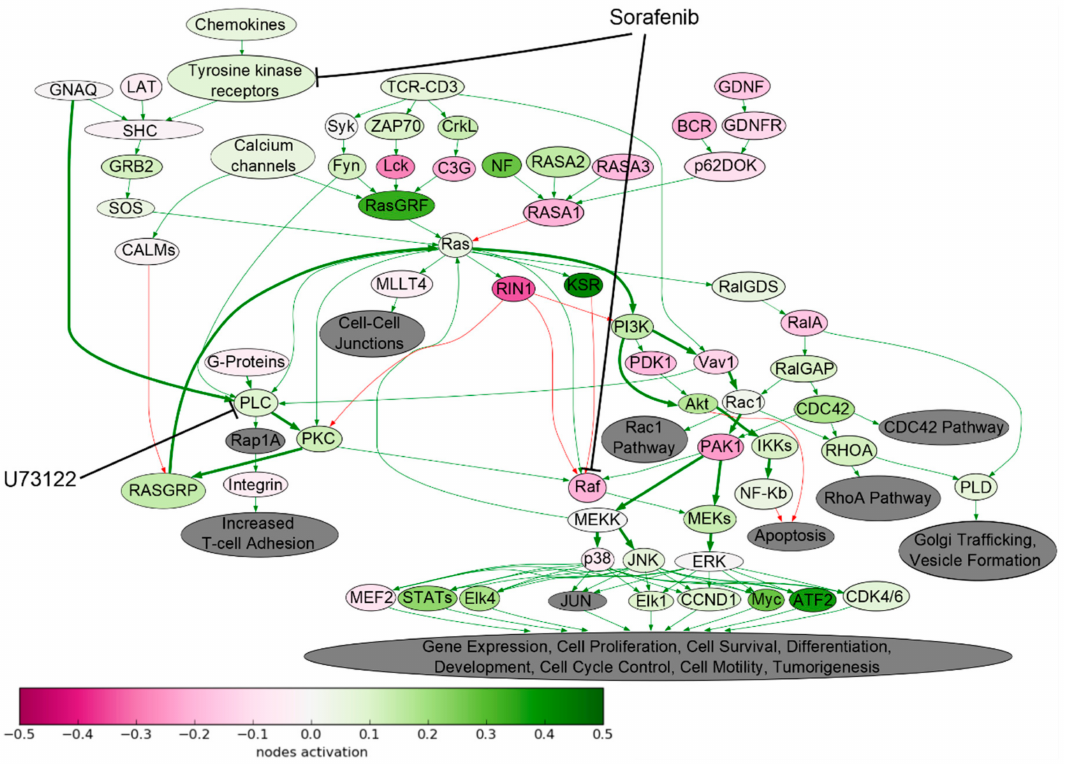
Figure 8. Ras pathway was hyperactivated in Sorafenib-resistant SKOV-3 cells. The pathway was visualized using Oncobox software. The pathway is shown as an interacting network, where green arrows indicate activation and red arrows indicate inhibition. Color depth of each node of the network corresponds to the logarithms of the case-to-normal (CNR) expression rate for each node, where “normal” is a geometric average between intact SKOV3 cells, the scale represents extent of up/downregulation. The molecular targets of Sorafenib and U73122 are shown by black arrows. Predicted bypass of nodes targeted by Sorafenib is shown on bold